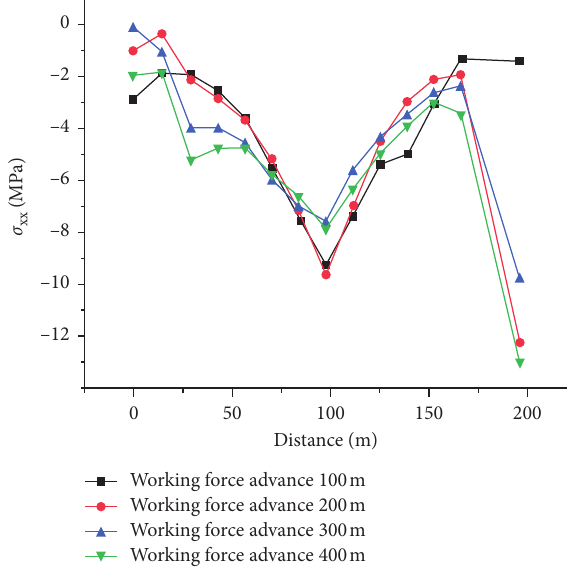
Figure 14: The horizontal stress of monitoring points in the third left working